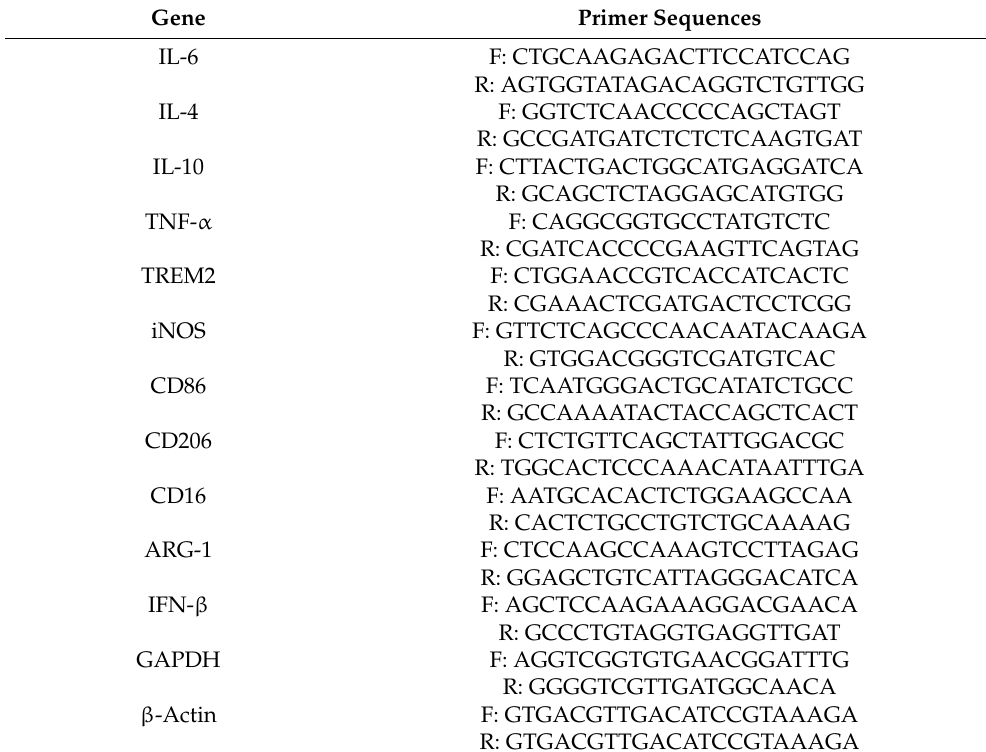
Table 1. Primer sequences used for quantitative